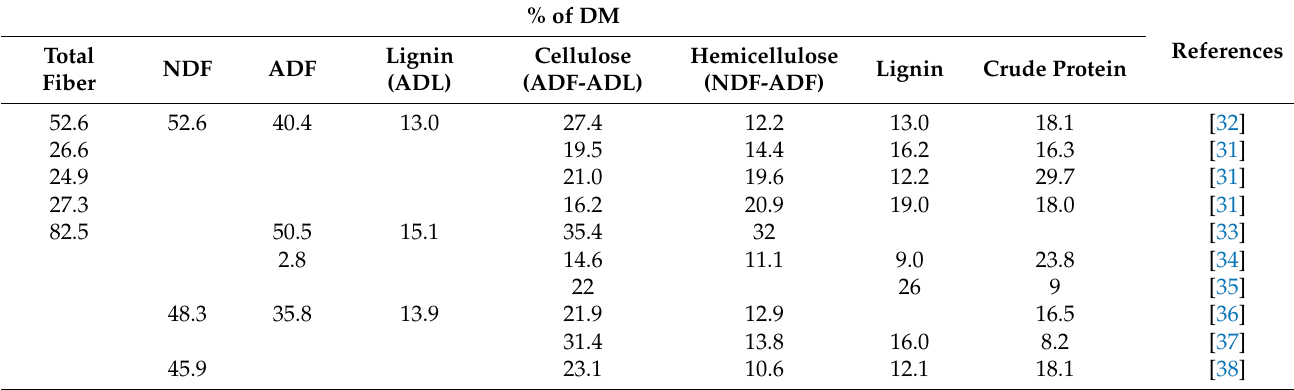
Table 2. The content of cattle manure. % of